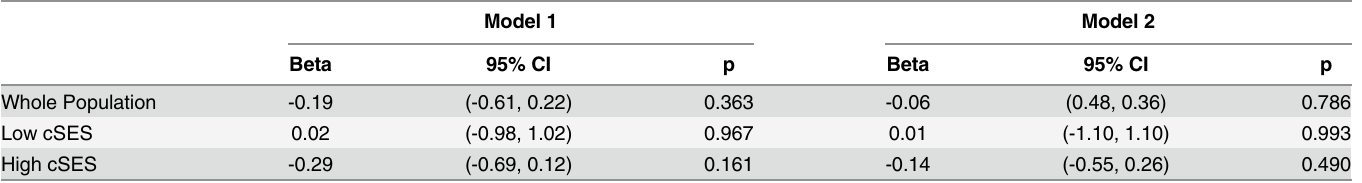
were coarsened to facilitate matching Model 2: Model 1 with additional adjustment for respondent ’ s education (linear spline) There were 321 individuals included in the analytic sample when cSES was dichotomized by father ’ s education ( < 8 years = low cSES, N = 96; > = 8 years = high cSES, N = 225).